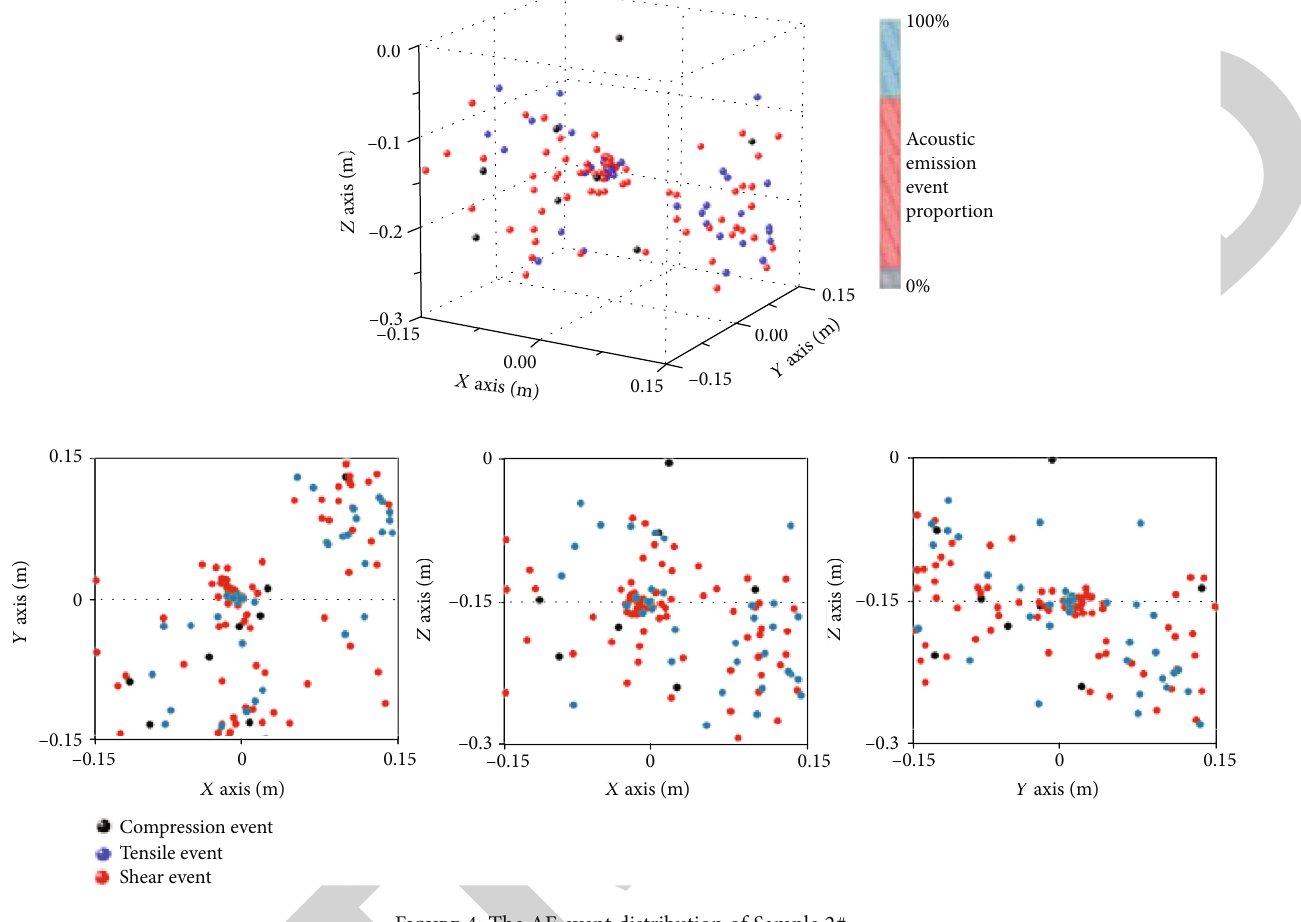
Figure 4: The AE event distribution of Sample